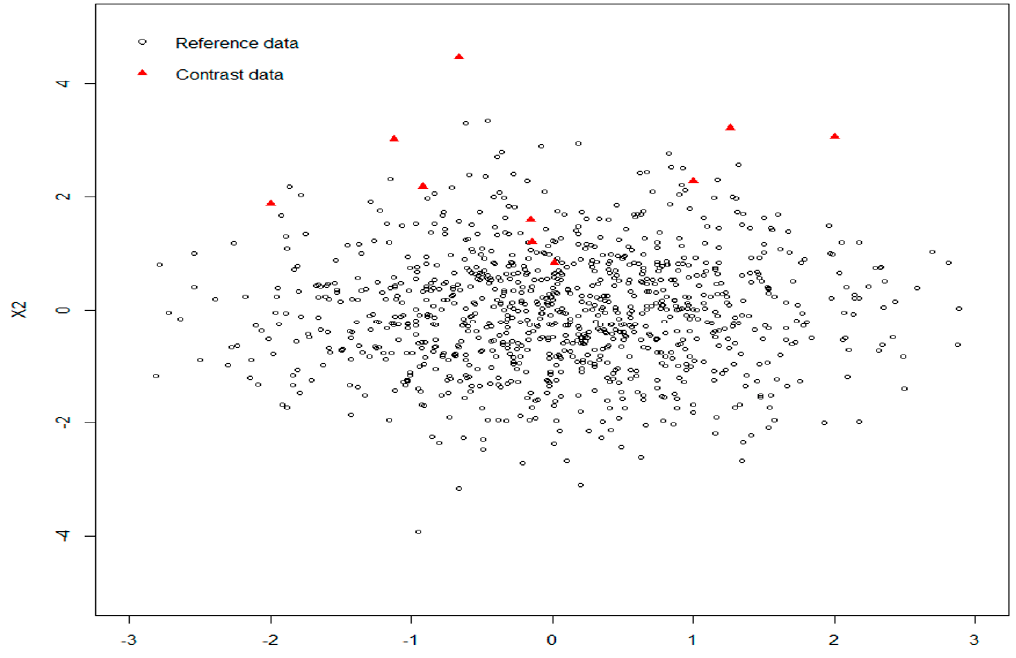
Figure 4. Abnormal state data in sliding window.